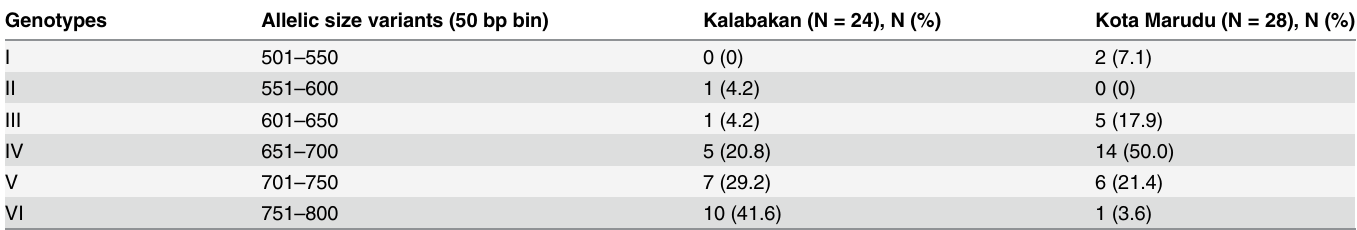
Table 5. Distribution of allelic variants of GLURP RII repeat region of P . falciparum populations in Kalabakan and Kota Marudu.